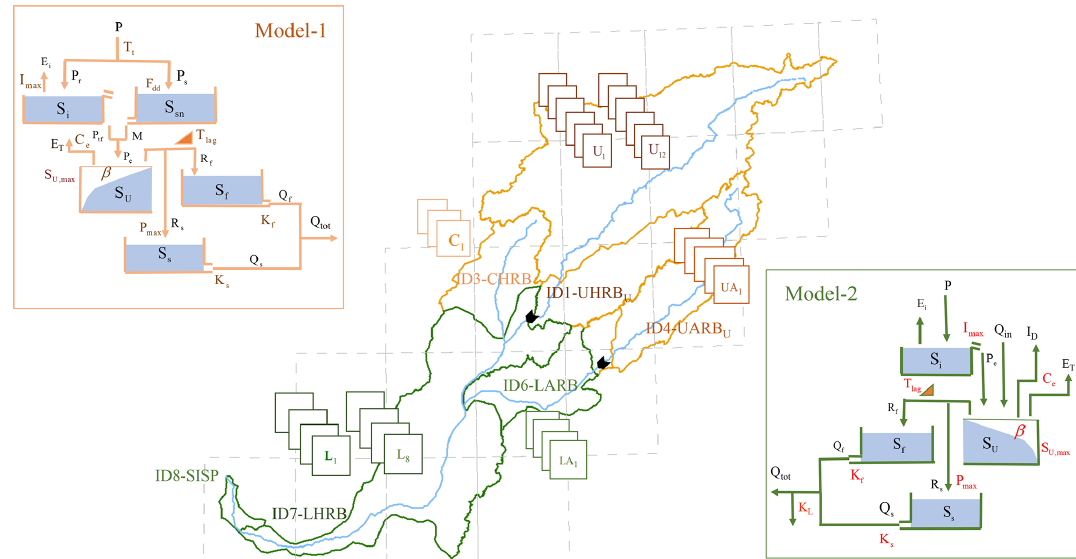
Figure 3. The distributed model structure consisting of parallel components (the structure of model 1 used for the UHRB, CHRB, and UARB; model 2 is used in the LHRB, LARB, and SISP) and 32 units of the CRU grid cell, representing one sub-basin each, characterized by an individual parameter set. Variables: P – total precipitation [mmd − 1 ]; P s – snowfall [mmd − 1 ]; P r – rainfall [mmd − 1 ]; M –